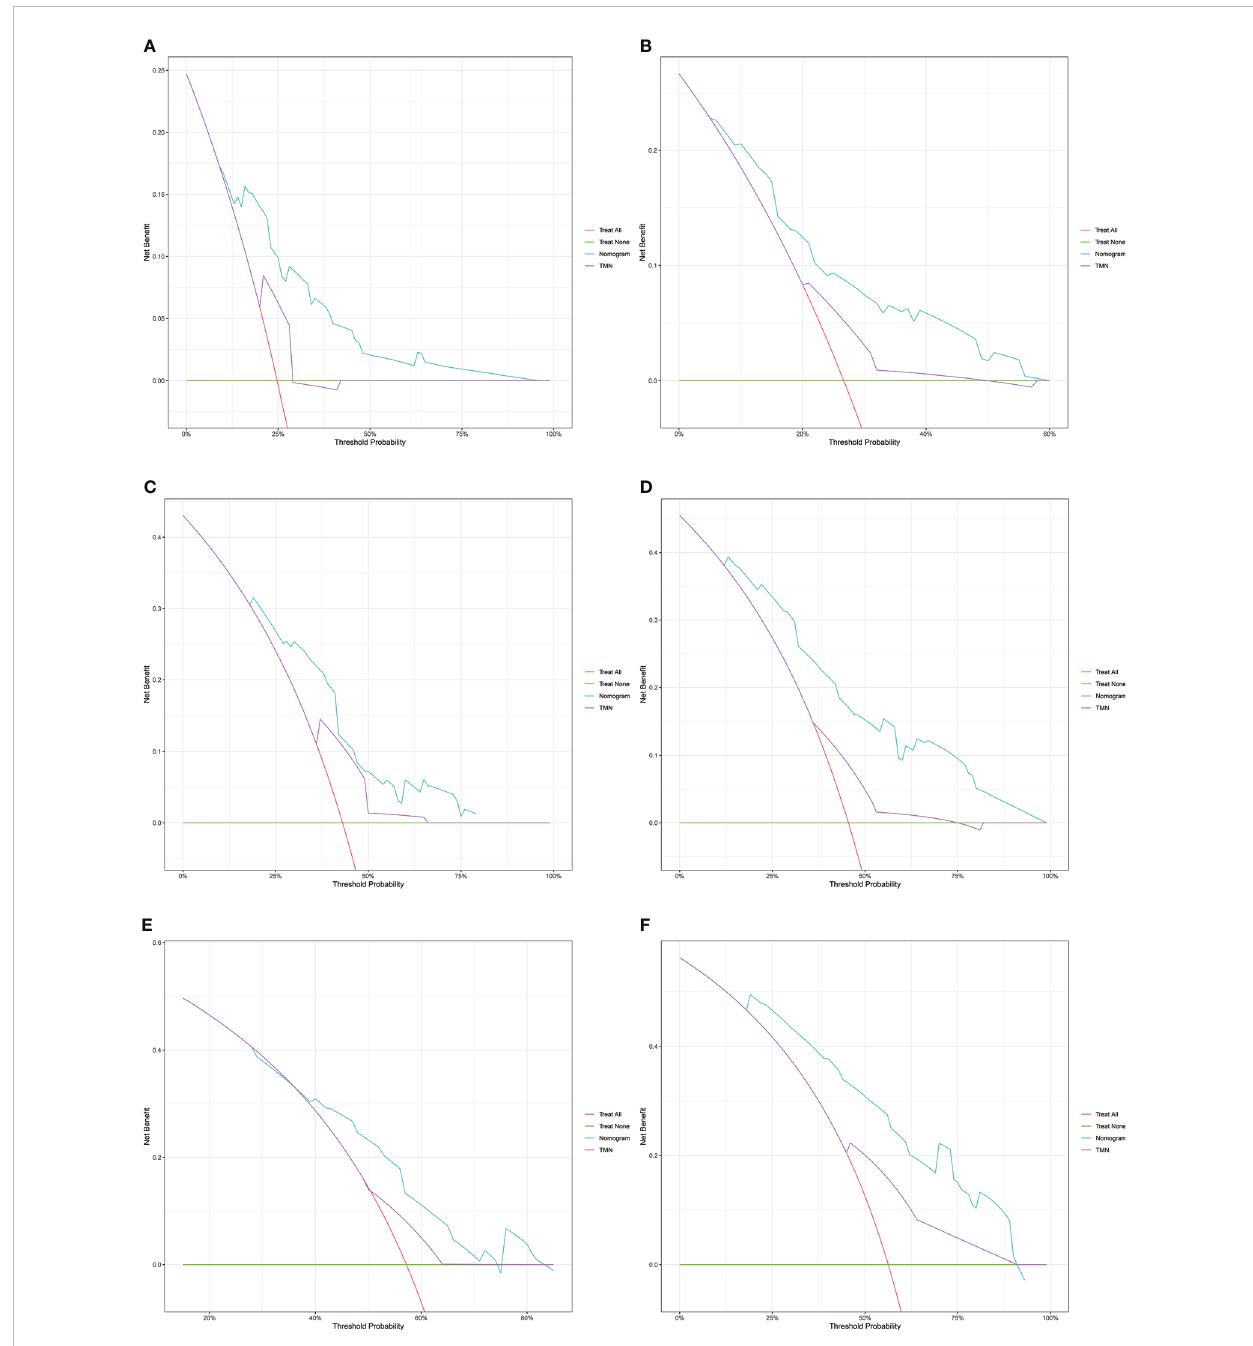
FIGURE 6 The decision curve analysis of the nomogram for 1-year, 1.5-year and 2-year survival of patients with resectable pancreatic cancer in the training cohort (A – C) and validation cohort (D – F) . TNM: tumor node